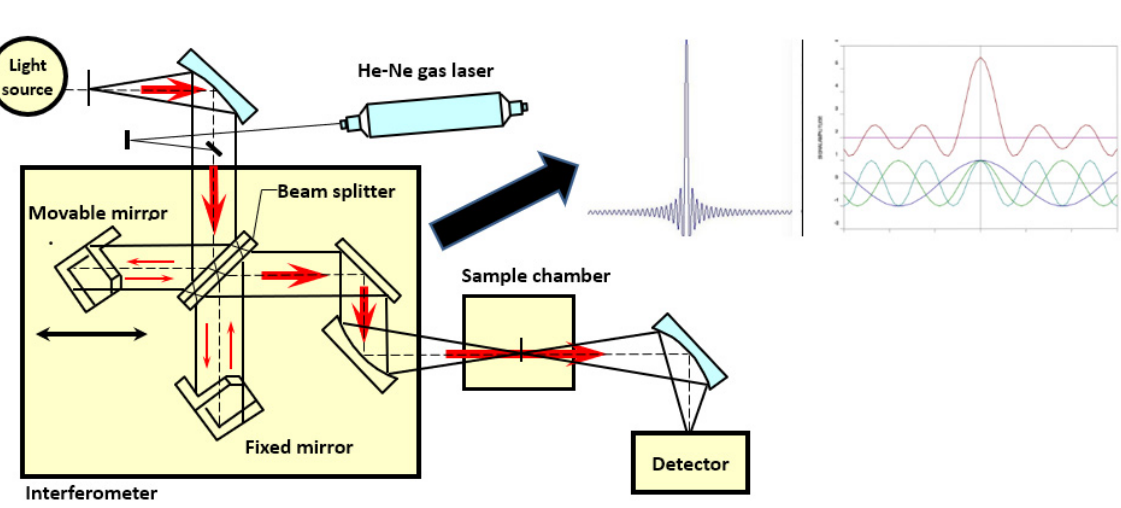
Figure 1. Mechanism of FTIR Interferometer (Ref. [16] and used under copyright permission through http://delloyd.50megs.com/newfolder/copyright.html, accessed on 3 December 2022).